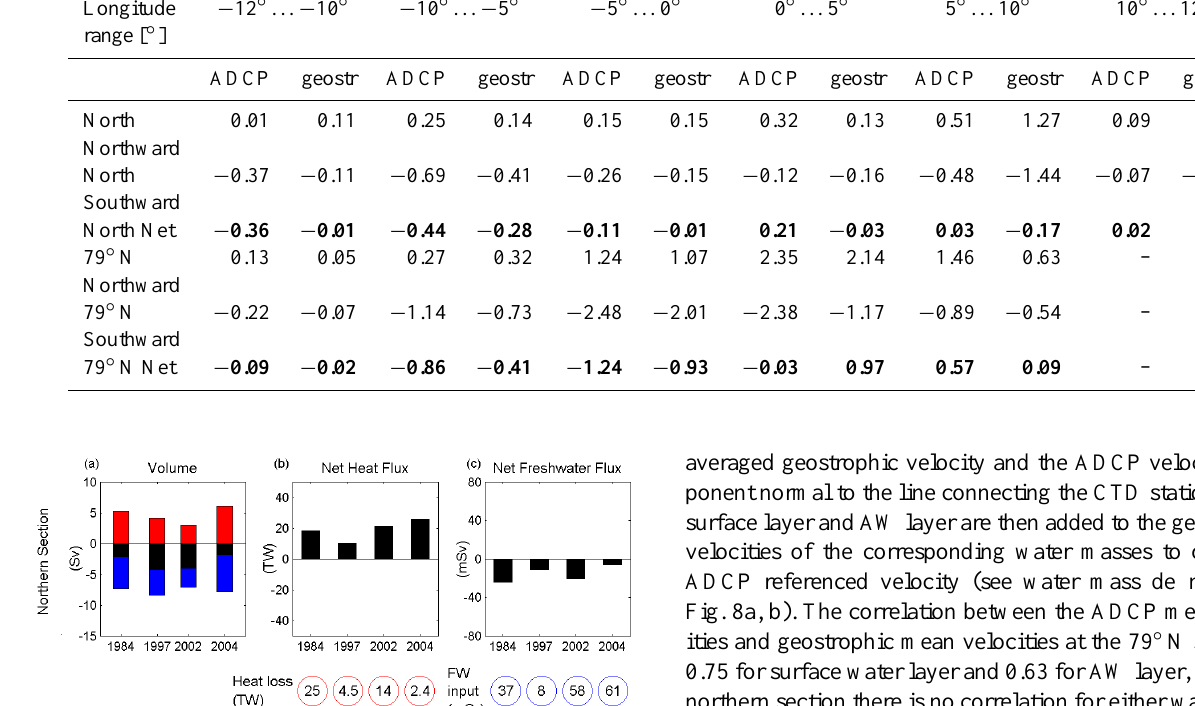
northern section there is no correlation for either water mass.